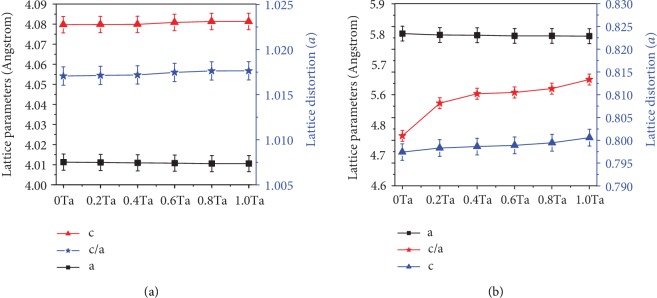
Calculating results of a, c, and c/a of Ti46Al8Nb2.6CxTa alloys: (a) the gamma phase; (b) the alpha2 phase.